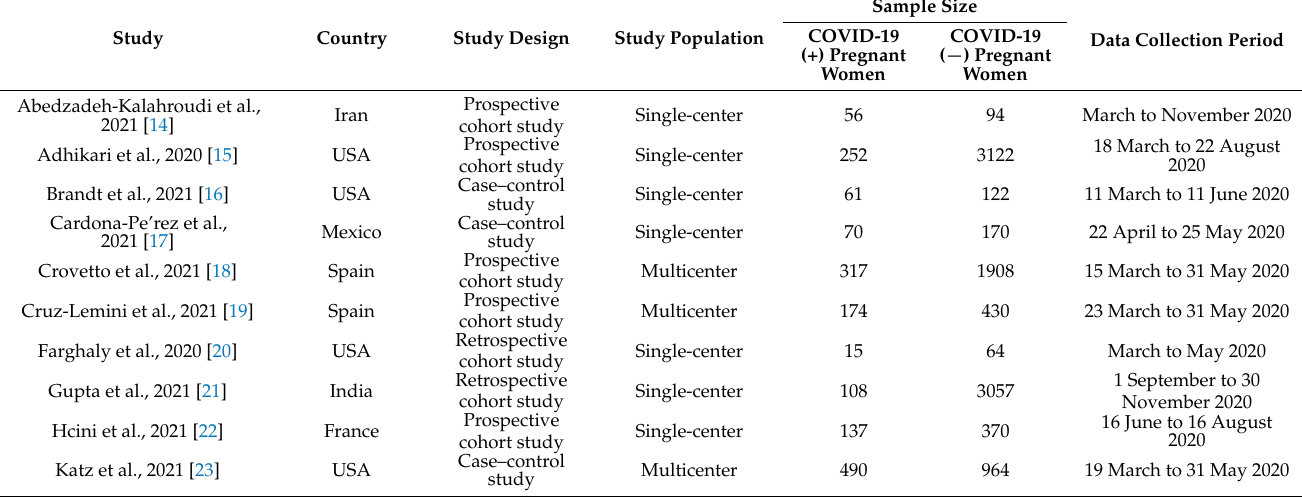
Table 1. Characteristics of included studies.